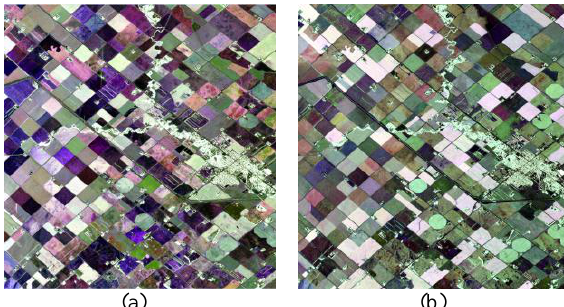
Figure 4. Pauli decomposition of sub-sample images acquired in (a) 17 Jun and (b) 17 July 2012.